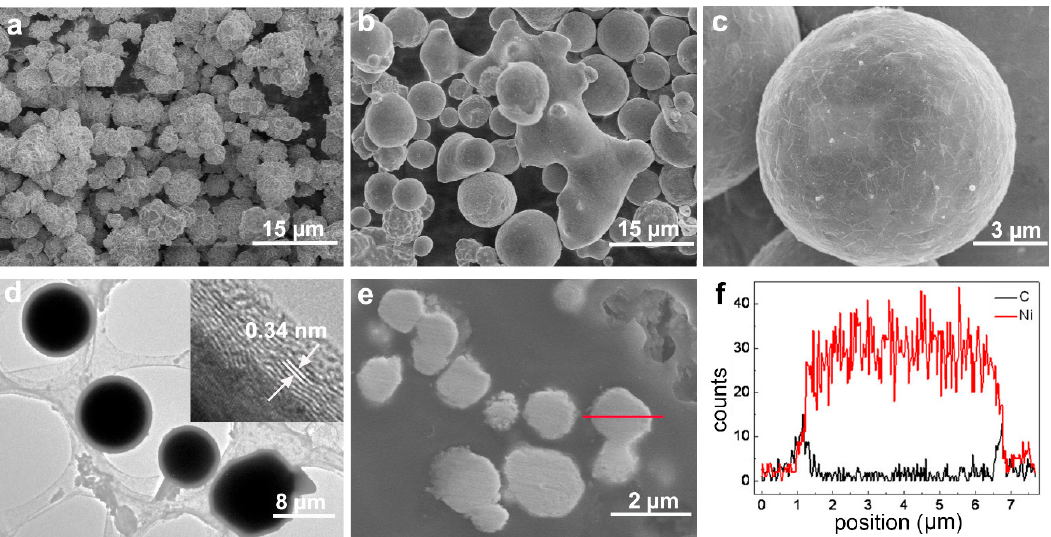
Figure 1. Morphology and composition of Ni particles before and after laser irradiation. ( a ) SEM image of raw (precursor) Ni particles. ( b ) SEM image of Ni particles irradiated for 30 min at laser energy of 20.2 J/pulse. ( c ) High magnification SEM image of a single particle in panel. ( d ) TEM image of laser ‐ treated Ni particles with carbon coating, the inset is a HRTEM image showing a surface carbon layer. ( e ) SEM image of cross ‐ sectional sample with laser ‐ treated Ni particles. ( f ) Elemental line ‐ scan profiles along the red line shown in ( e ).